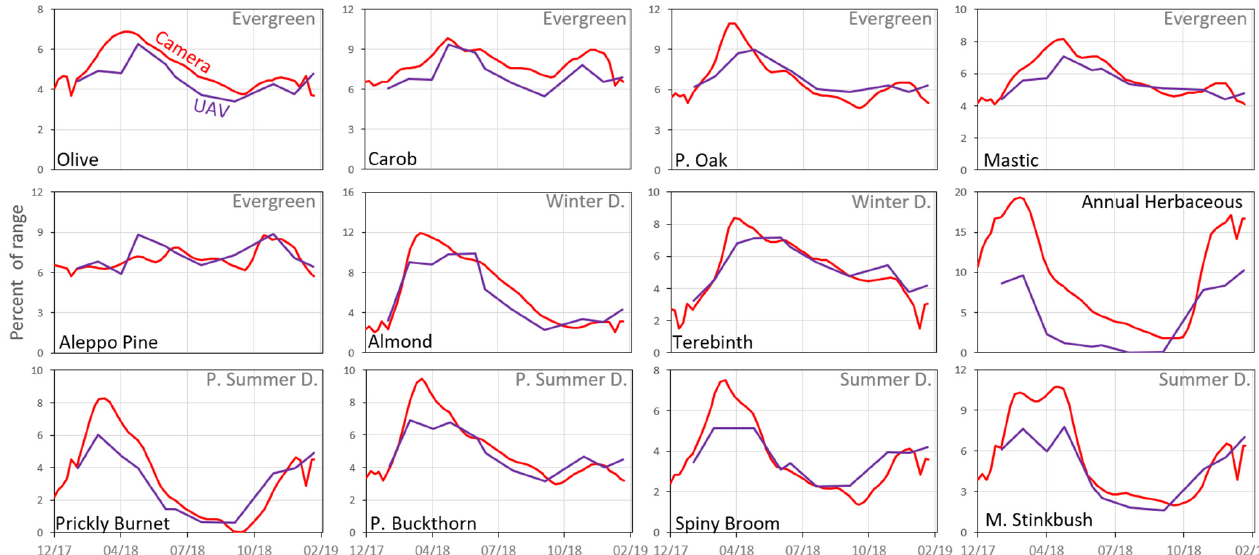
Figure 7. Standardized mean ExG values for the 12 species based on the ground photos after preprocessing (57 dates), and UAV data (11 dates, 14 cm resolution). The y -axis represents the index mean value as a percent of the range of the possible values for each sensor.